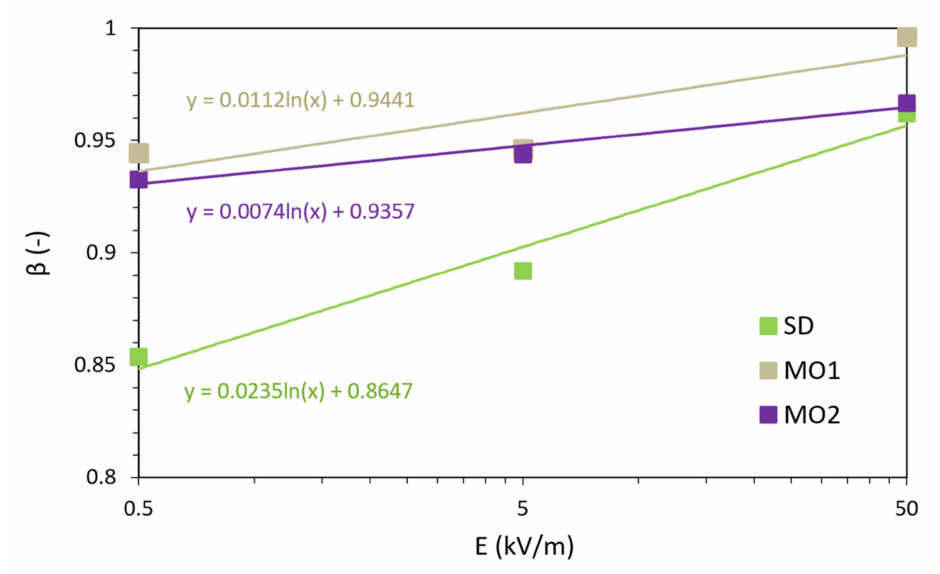
Figure 11. Regression lines of β parameter depend on the intensity E of the time-varying electric field.